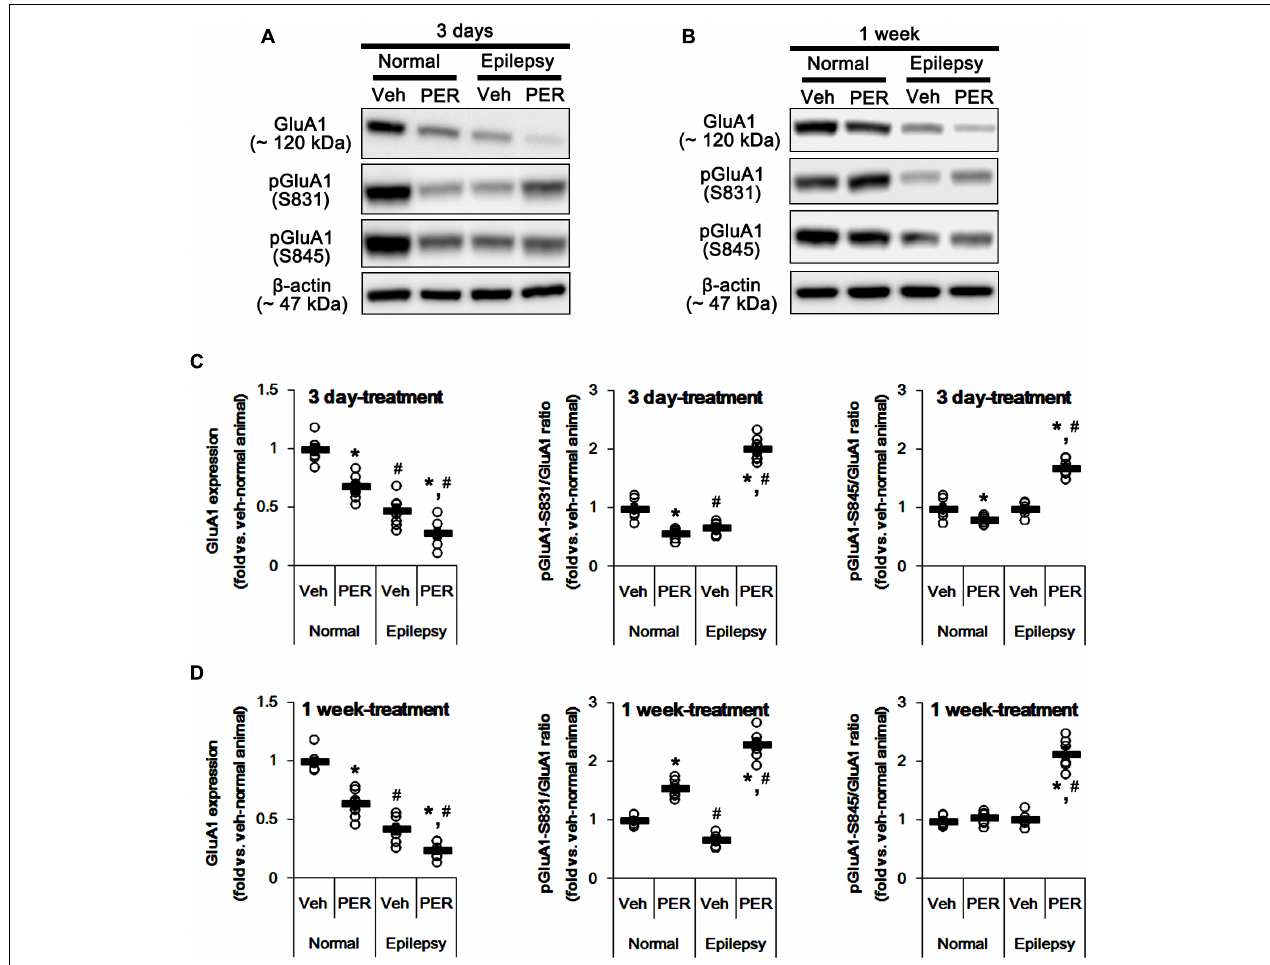
FIGURE 3 | Effects of perampanel on GluA1 expression and its phosphorylations. (A,B) Representative images for western blot of GluA1, phospho (p)-GluA1-S831, and pGluA1-S845 in the hippocampal tissues obtained from 3-days (A) and 1-week treated groups (B) . (C,D) Quantifications of GluA1, pGluA1-S831, and pGluA1-S845 levels in 3-days (C) and 1-week treated groups (D) . Open circles indicate each individual value. Horizontal bars indicate mean value. Error bars indicate SEM ( ∗ , # p < 0.05 vs. vehicle-treated animals and normal animals, respectively; n = 7, respectively).